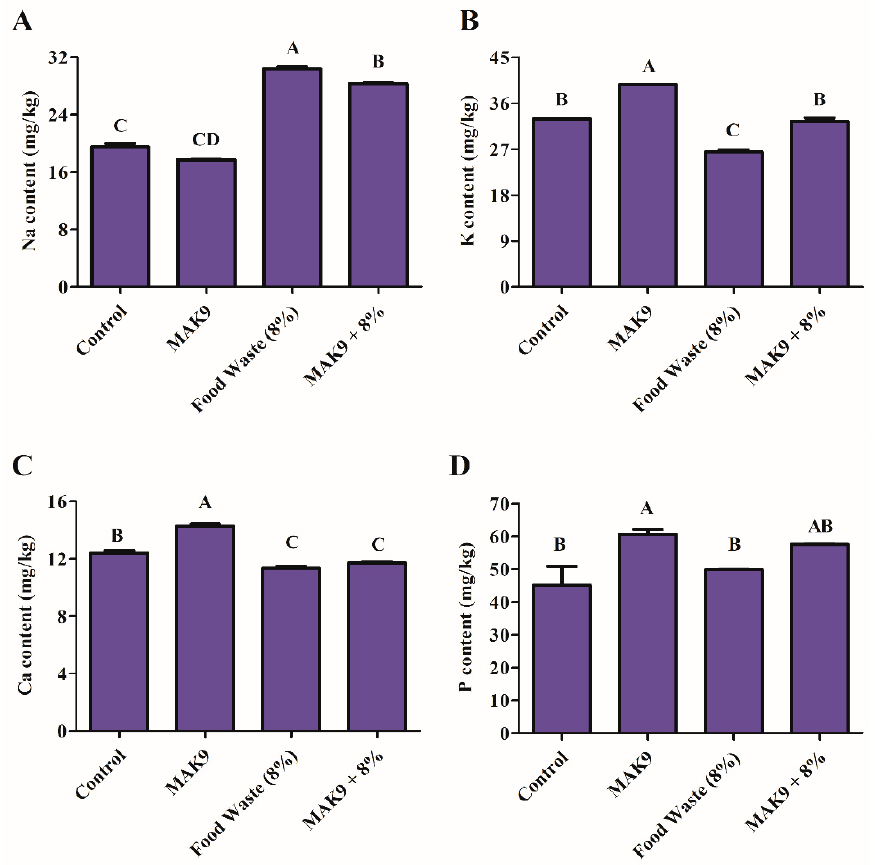
Figure 6. The effect of isolate MAK9 on the sodium (Na, ( A )); potassium (K, ( B )); calcium (C, ( C )); and phosphorus (P, ( D )) content of Chinese cabbage inoculated with isolate MAK9 and/or treated with food waste (8%). Different letters indicate differences between the mean values of three replicates ± standard deviations.